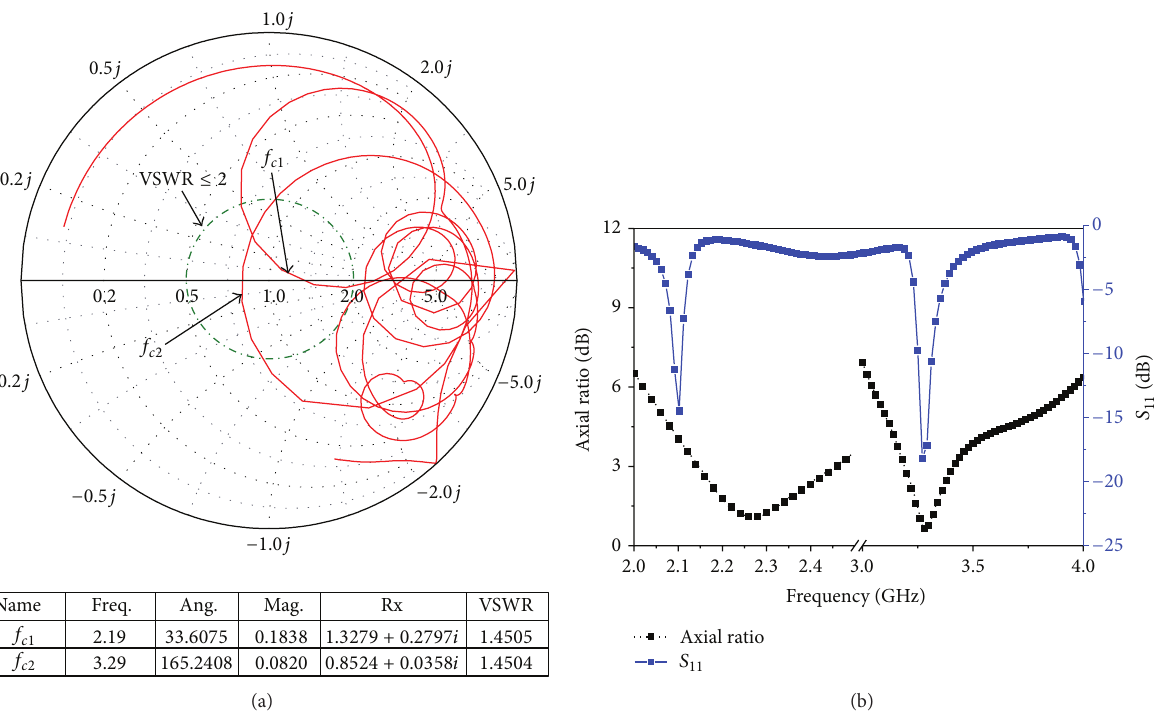
Figure 3: Simulated results for the proposed antenna with optimized parameter Table 1. (a) Smith chart and (b) reflection coefficient and axial ratio.